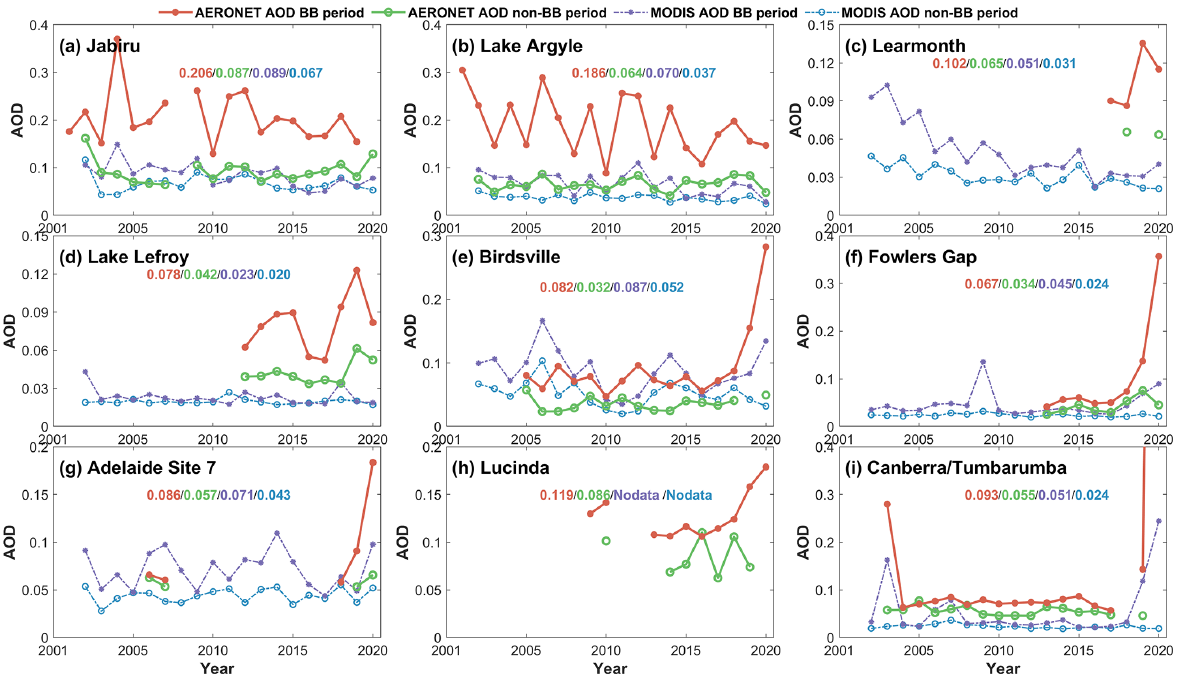
Figure 3. Temporal variations of annual mean AERONET AOD at 500nm and Aqua MODIS DB AOD at 550nm during the BB period and the non-BB period at nine sites in Australia. The numbers above the graphs with different colors refer to the corresponding average values.